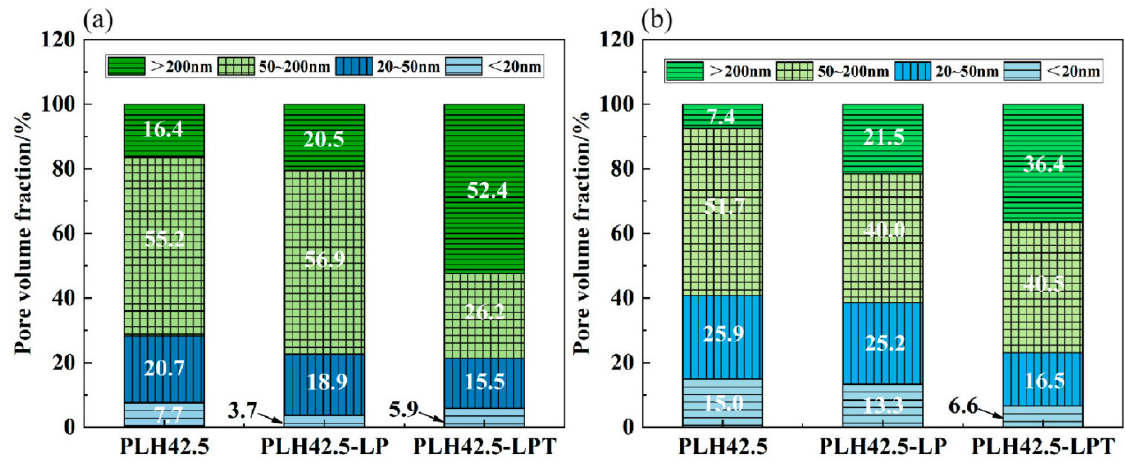
Figure 8. Pore volume fractions of the hardened pastes after curing for ( a ) 28 and ( b ) 90